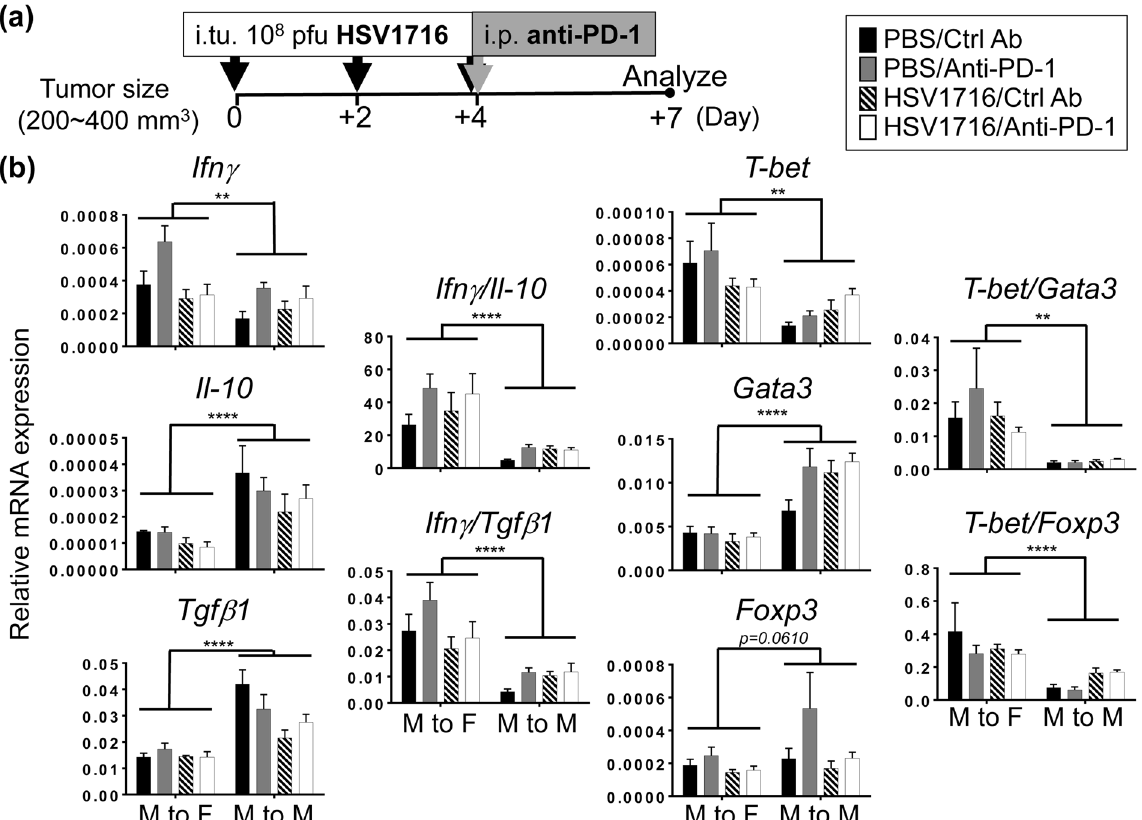
Figure 5. Tumors in female mice are more inflammatory than those in male mice. ( a ) Schematic illustrates the dosing regimens and sample collection. Female (M to F) or male (M to M) M3-9-M tumor-bearing mice received three doses of intratumoral (i.tu.) HSV1716 injection followed by intraperitoneal (i.p.) injection of anti-PD-1 or control antibody. Tumors were harvested 72 hours after last dose of HSV1716 injection. Th1 and Th2 related genes in tumors were evaluated by quantitative real-time PCR analyses. ( b ) Data show mean and SEM (n = 4~6 per treatment group). Statistical analysis was performed by a two-way ANOVA ( * p < 0.05, ** p < 0.01 and *** p <